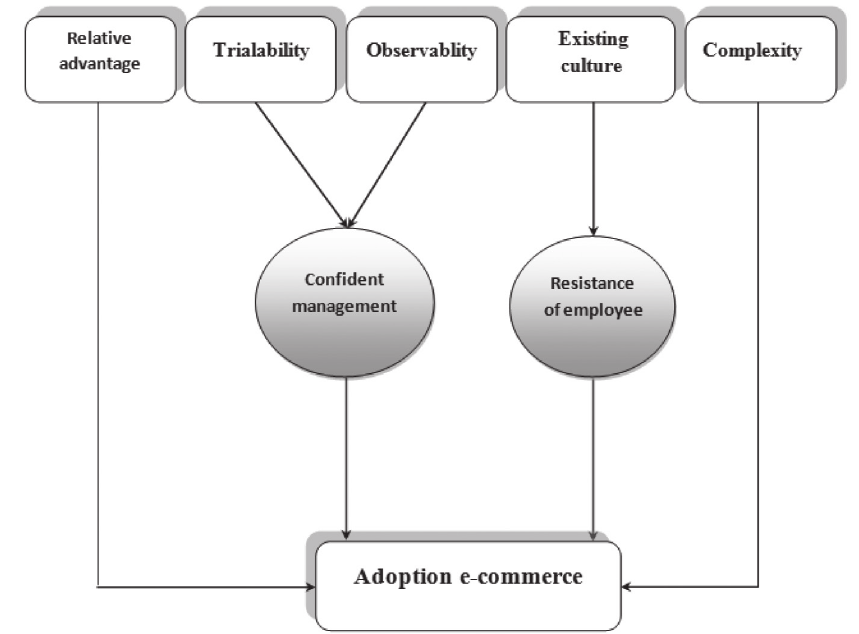
Figure 2 - Conceptual